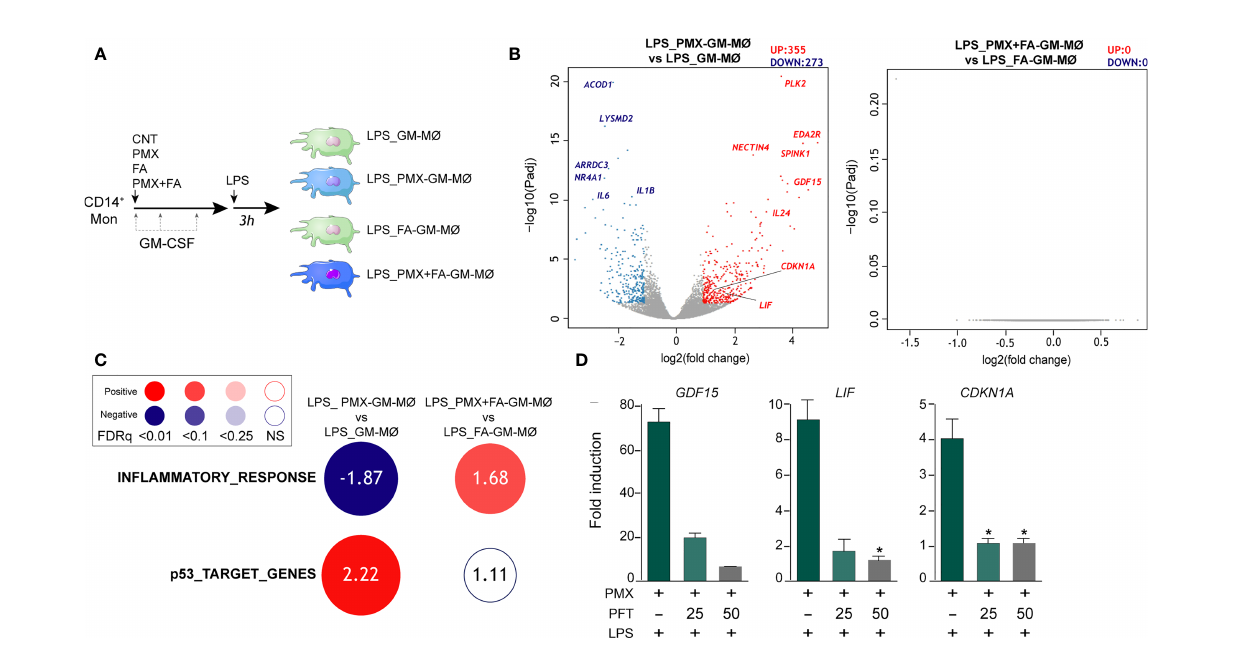
FIGURE 2 | PMX promotes a transcriptional state of LPS tolerance. (A) Experimental design. Monocytes were untreated (GM-MØ), exposed to 50 nM of PMX (PMX- GM-MØ), 5 m M of folinic acid (FA-GM-MØ), or both (PMX+FA-GM-MØ) at the beginning of the 7-day macrophage differentiation process with GM-CSF and challenged with LPS (10 ng/ml) on day 7. Cells were assayed 3 h post LPS stimulation. (B) Volcano plot of RNAseq results showing gene expression changes 3 h post-LPS stimulation in PMX-treated GM-MØ (LPS_PMX-GM-MØ/LPS_GM-MØ, left) and PMX+FA-treated GM-MØ (LPS_PMX+FA-GM-MØ/LPS_FA-GM-MØ, right). The number of annotated genes whose expression is upregulated or downregulated 3 h post-LPS stimulation in GM-MØ after 7 days of PMX, FA, or PMX+FA treatment (adjusted p < 0.05) is shown. (C) Summary of GSEA with the indicated gene sets on the ranked comparison of the transcriptomes of LPS-treated PMX-GM-MØ vs . LPS-treated GM-MØ, and LPS-treated PMX+FA-GM-MØ vs . LPS-treated FA-GM-MØ. Circled area is proportional to the absolute value of the normalized enrichment score (NES), which is indicated inside the circles. The intensity of color increases with the enrichment of the gene signature (red, positive enrichment; blue, negative enrichment). False discovery rate (FDRq) is also indicated. The gene sets used were the Hallmarks v7.2 data set available at the web site and the “ p53_Target_Gene ” data set (32). (D) Gene expression determined by qRT-PCR on monocytes stimulated with PMX in the absence or presence of pi fi thrin- a (PFT, 25-50 m M) during the GM-CSF- dependent differentiation process and challenged with LPS for 3 h. Mean ± SEM of four independent donors are shown (* p < 0.05). Results are expressed as fold induction, which indicates the expression of each gene in PMX-exposed relative to control cells, and untreated or treated with PFT. PMX, pemetrexed; LPS, lipopolysaccharide; GSEA, gene set enrichment